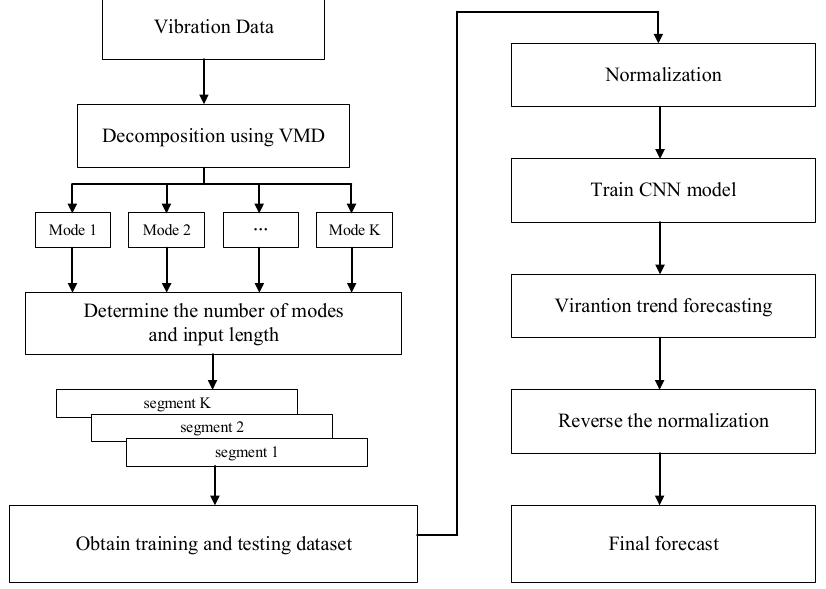
Figure 1. The architecture of the proposed variational mode decomposition (VMD)-convolutional neural network (CNN) hybrid data-driven forecasting model.